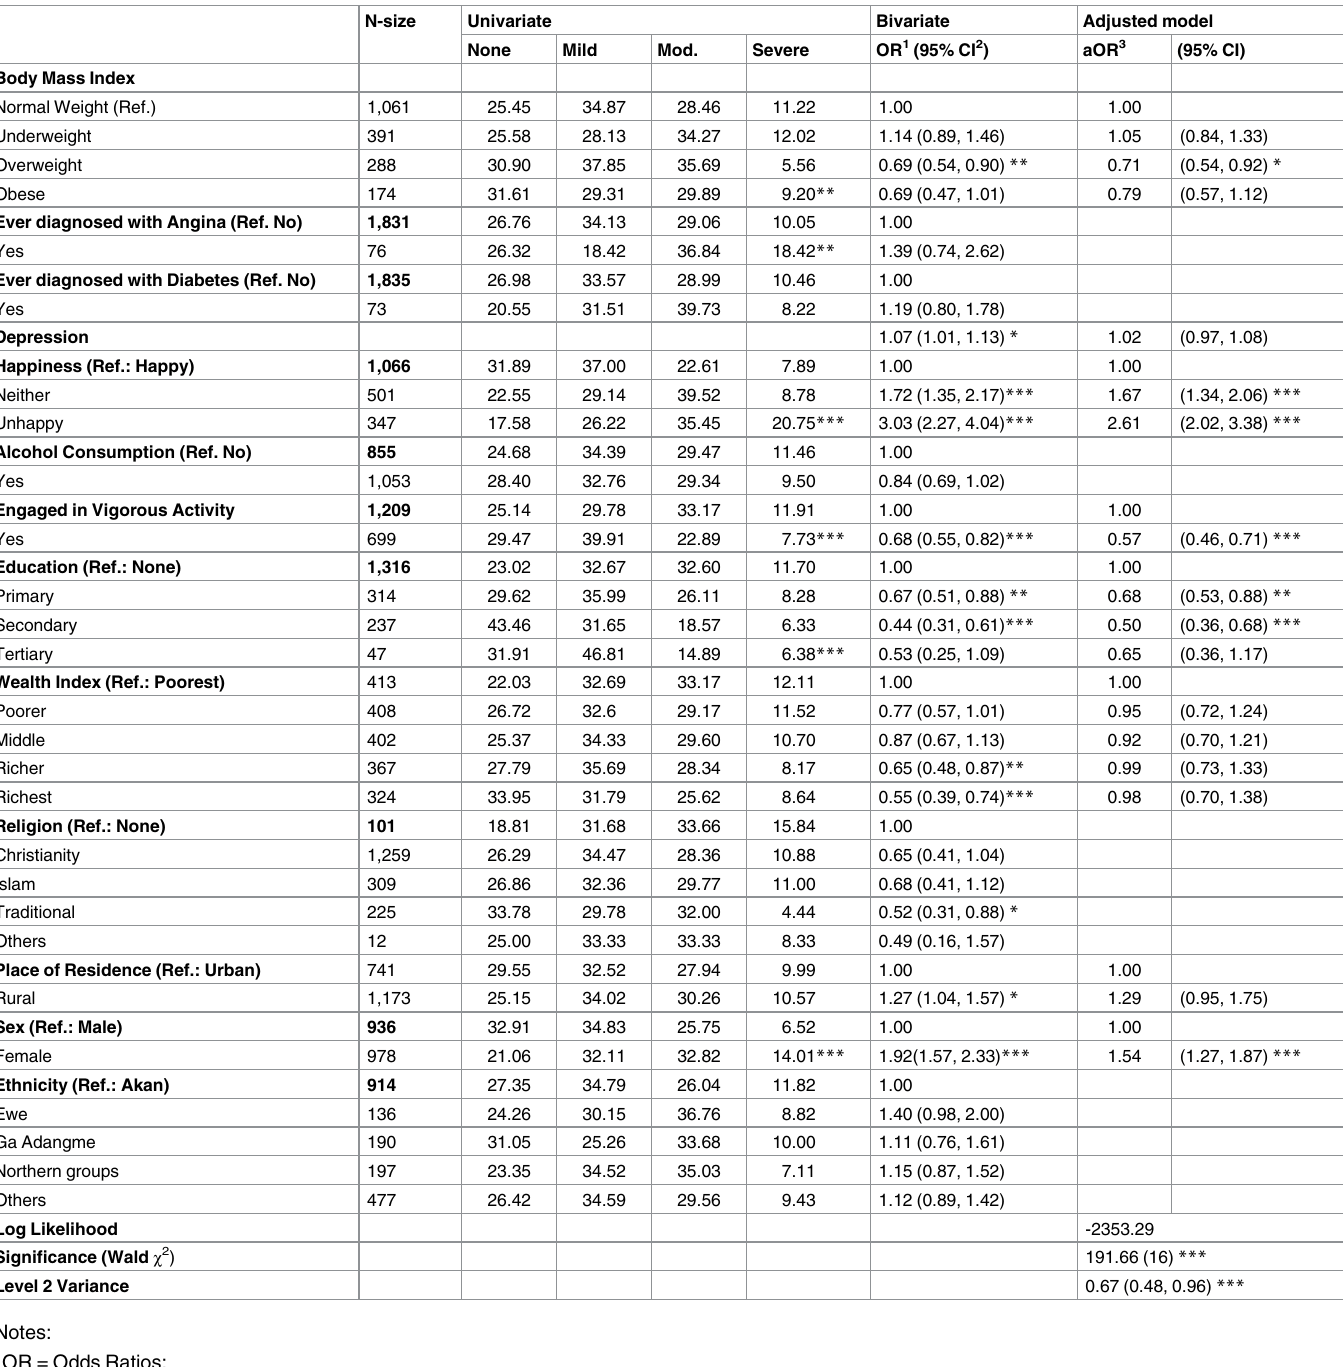
Table 4. Univariate, bivariate and adjusted results of generalized linear mixed effect ordinal logit models of difficulties with recall on elderly obesity. N-size Univariate Bivariate Adjusted model None Mild Mod. Severe OR 1 (95% CI 2 ) aOR 3 (95% CI) Body Mass Index Normal Weight (Ref.)